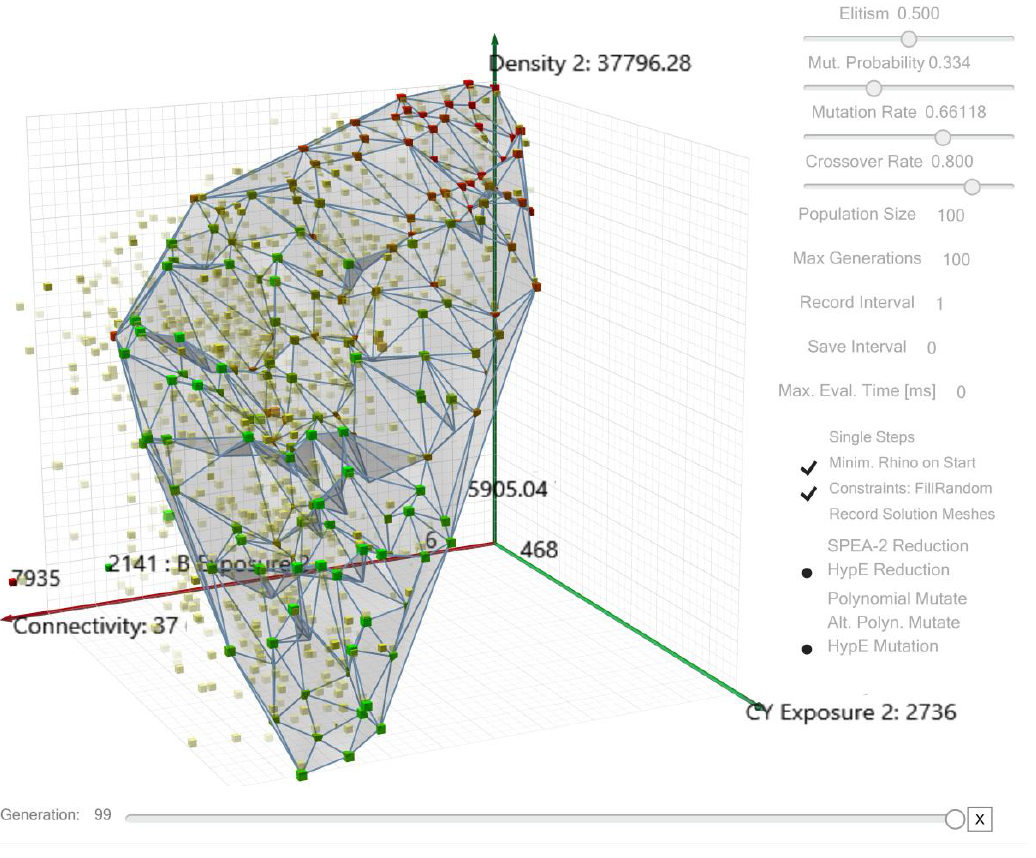
Figure 6. Octopus plugin screenshot. Since 4 fitness criteria have been set, the Pareto front is also composed of 4 dimensions. Therefore, a color gradient is represented on top of a 3-dimensional mesh to represent the 4th criteria (from green to red).